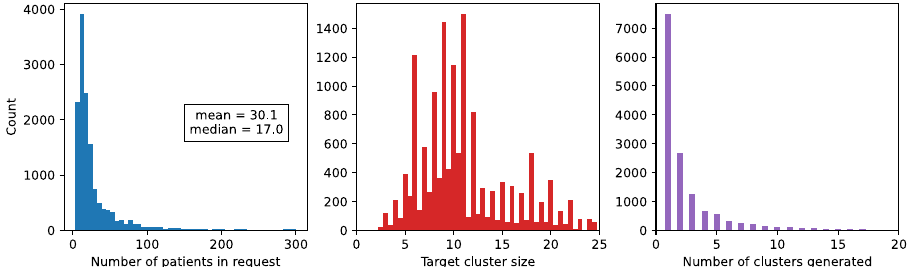
Fig. 4 Histograms of user request characteristics. Left: total number of patients uploaded in request. Centre: target cluster size for request. Right: number of clusters generated for request.